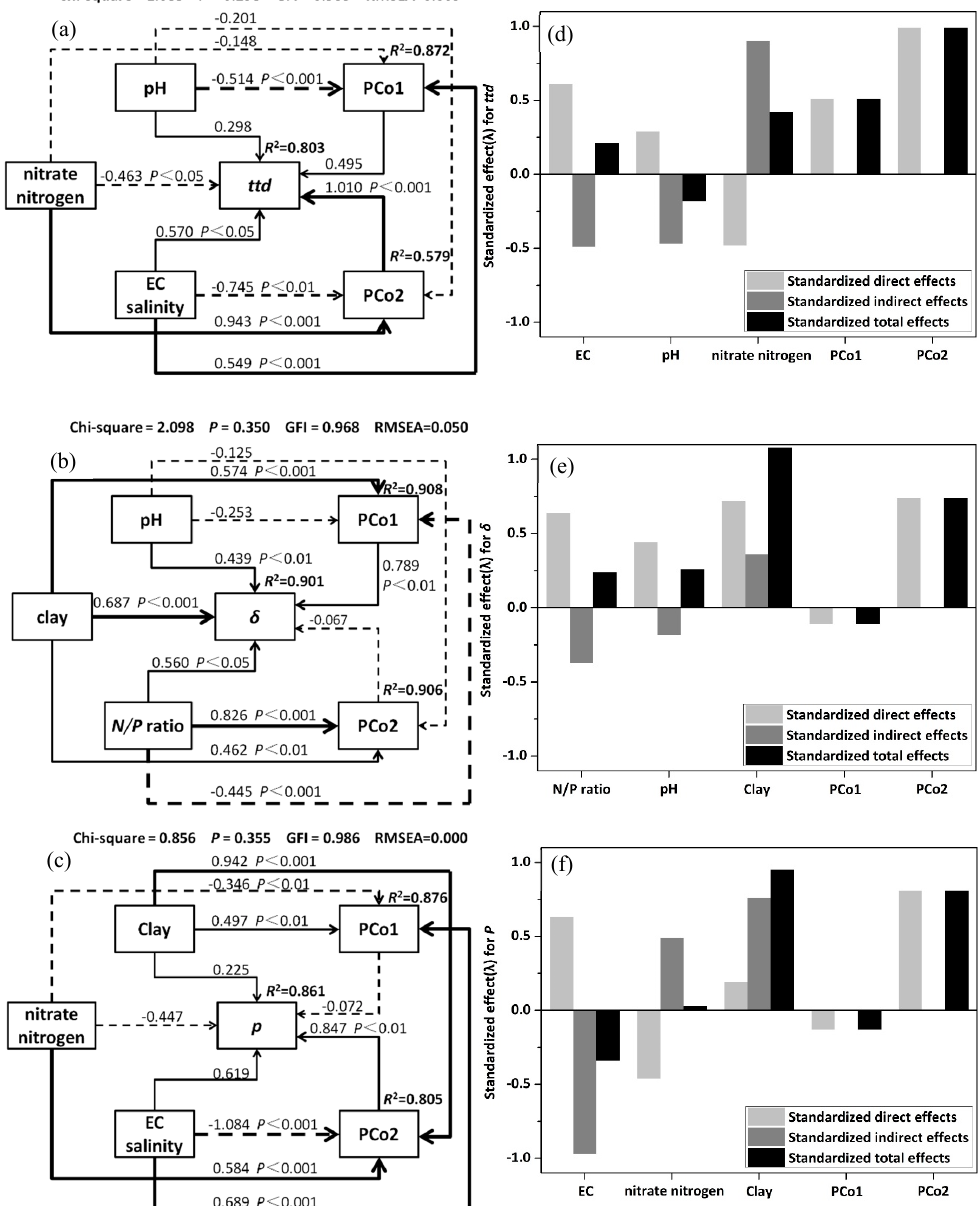
Figure 7. Structural Equation modeling (SEM) quantified the indirect and direct effects of soil properties and fungal communities on the survival parameters ( ttd , δ , and p ) of E. coli O157:H7 (Figure 7a–c). The width of the arrow indicates the strength of the normalized path coefficient ( λ ). The solid and broken lines indicate the positive and negative path coefficient, respectively. The R 2 value represents the proportion of the variance explained for each variable. The total effect was the sum of direct and indirect effects. The first 2 coordinates (PCo1, PCo2) of the principal coordinate analysis were used to represent the fungal community composition.